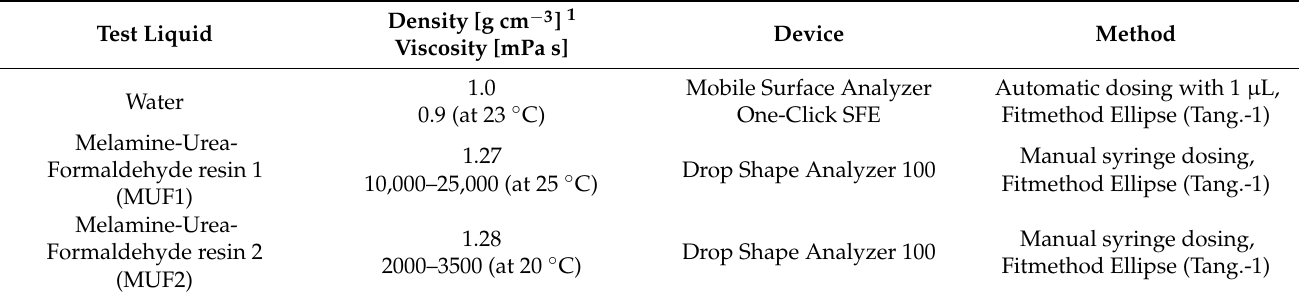
Table 1. Basic information on the contact angle measurement for the evaluation of